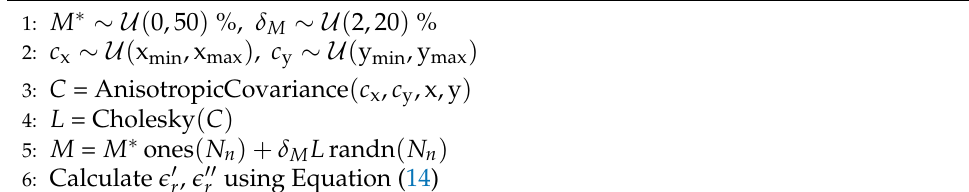
Algorithm 1 Pseudocode for generating the moisture distribution. Note that a small diagonal component is added in matrix C to ensure the positive definiteness.